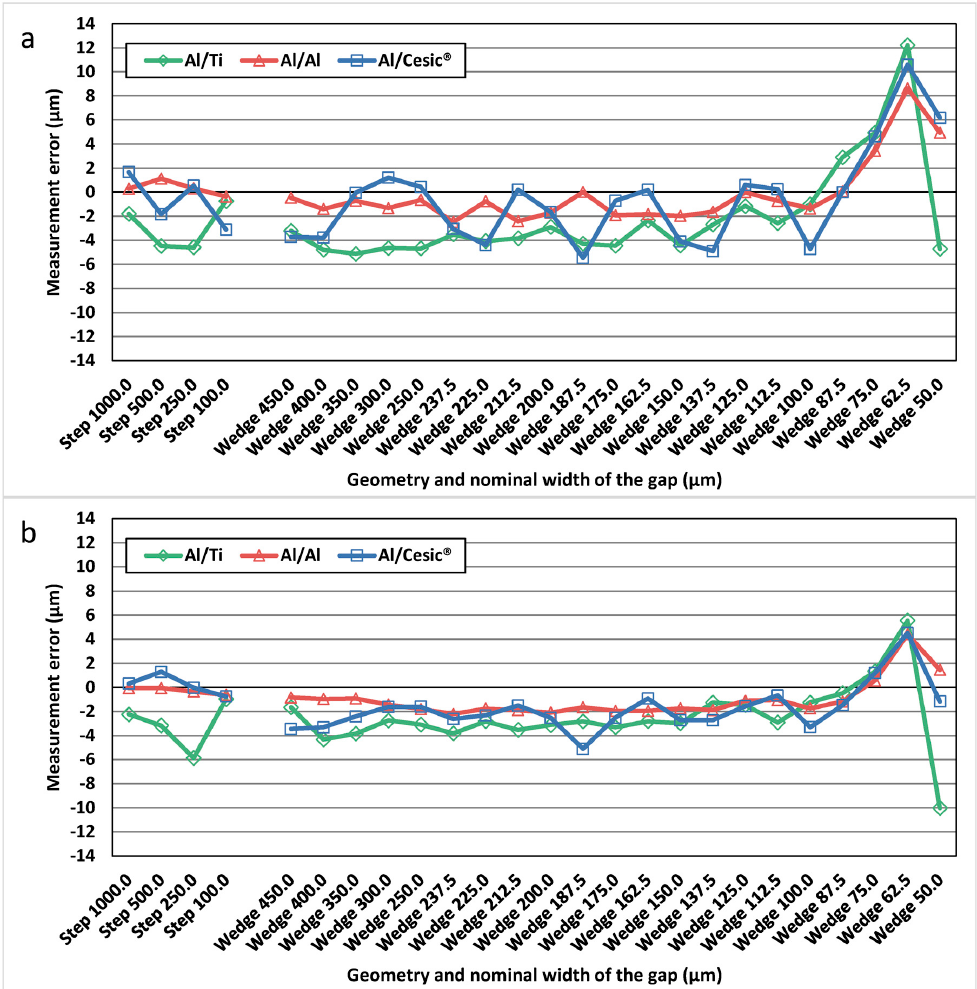
Figure 3. Measurement error using Canny-based algorithm ( a ) and Deriche-based algorithm ( b ) for the three reference standards (Al / Ti, Al / Al and Al / Cesic ®